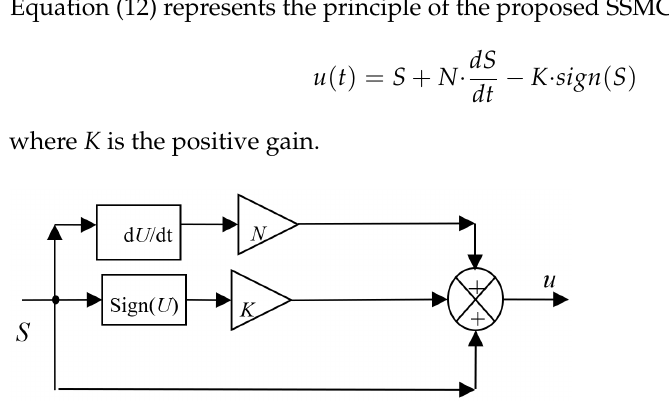
Figure 2. Proposed SSMC controller.